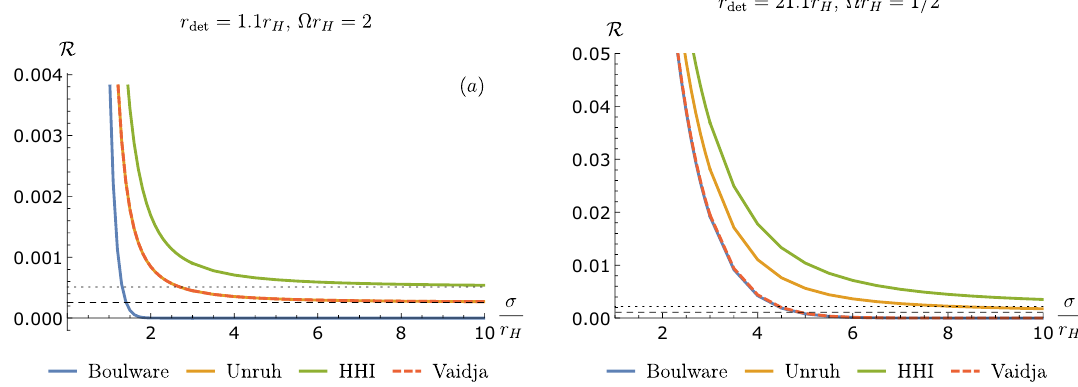
Figure 10 . The excitation-to-deexcitation (EDR) ratio as a function of interaction time T in units of r H = 2 M for various vacua. In (a) we set (cid:10) r H = 2 with the detector is located at r = 2 : 2 M = 1 : 1 r H : The horizontal dotted line corresponds to the EDR value obtained from KMS detailed balance e (cid:0) (cid:12) loc (cid:10) = e (cid:0) 8 (cid:25) p 11 (cid:25) 0 : 000512, which is approached by HHI vacuum. The horizontal dashed line corresponds to the non-thermal EDR ratio associated with the Unruh vacuum in eq. (5.19) (2 e (cid:12) loc (cid:10) (cid:0) 1) (cid:0) 1 = (2 e 8 (cid:25) p 11 (cid:0) 1) (cid:0) 1 (cid:25) 0 : 000256. In (b) we depict the EDR ratios for (cid:10) r H = 1 = 2 with the detector is located at e = 21 : 1 r H